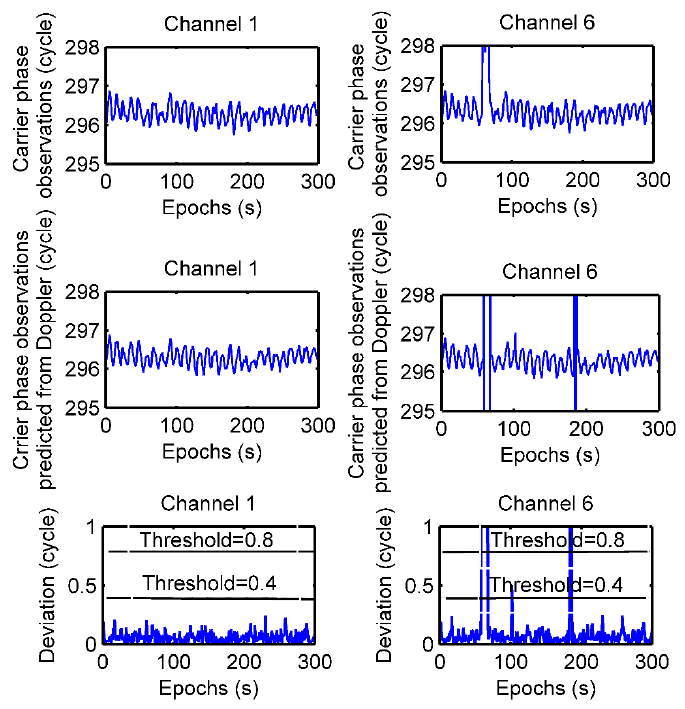
Figure 16. Static test of cycle-slip detection by the Doppler-aided cycle-slip detection method.